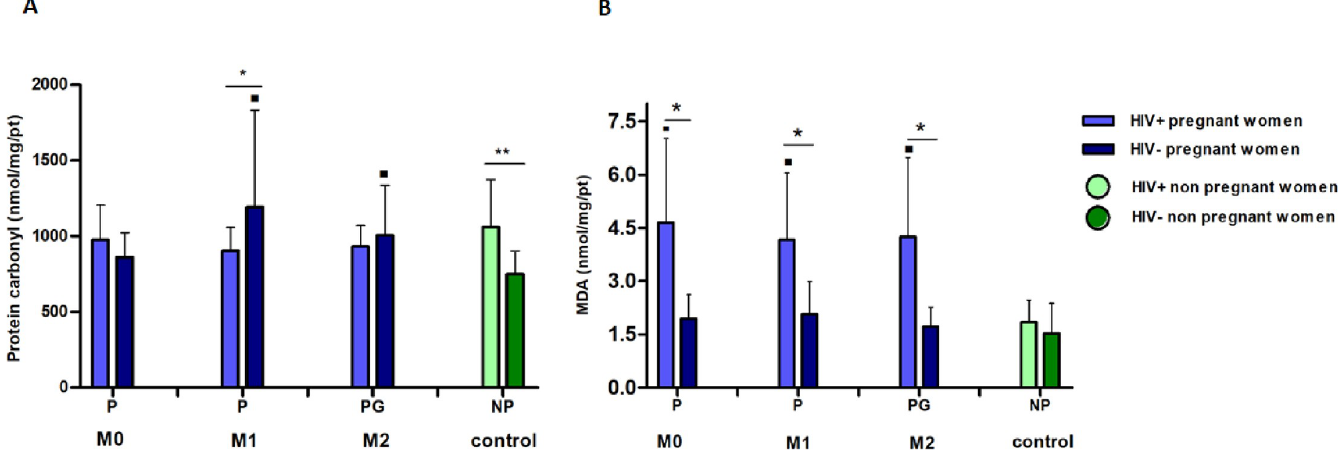
Fig 4. Factorial evaluation of oxidants markers (protein carbonyl and malondihaldeide [MDA]) from the 39 included women. M0: moment zero (first or second trimesters), M1: moment 1 (third trimester), M2: moment 2 (post-partum). M0 and M1 P: pregnancy. M2 PG: postpartum. Control NP: non-pregnant. NI: not infected, I: infected. A : M1 � G = i x ni p = 0 . 01 , - NI = g x ng p = 0 . 003 . M2 - NI = pg x ng p = 0 . 004 . Control �� NG = i x ni p = 0 . 002 . B : M0 � G = i x ni p = 0 . 002 , - NI = g x ng p = 0 . 001 . M1 � G = i x ni p = 0 . 003 , - NI = g x ng p = 0 . 009 . M2 � G = i x ni p < 0 . 0001 , - NI = g x ng p = 0 . 003 . Statistical analysis : Gamma Distribution .